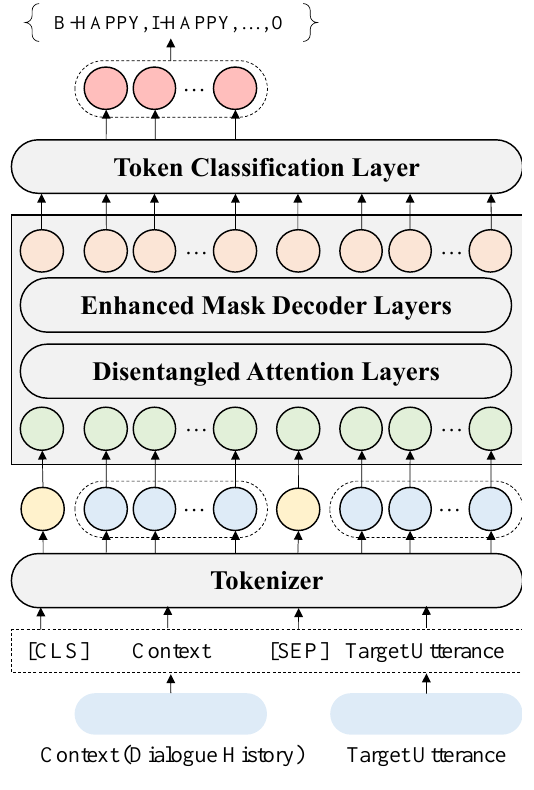
Figure 3. Model architecture. Figure 3. Model